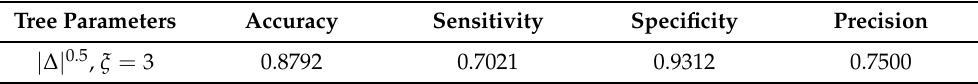
Figure 8. Decision tree and confusion matrix for metric | ∆ | 0.5 , using w h = 1, w g = 1.5 and ξ = 3. Table 10. Performance of the best classification tree ( w h = 1, w g =